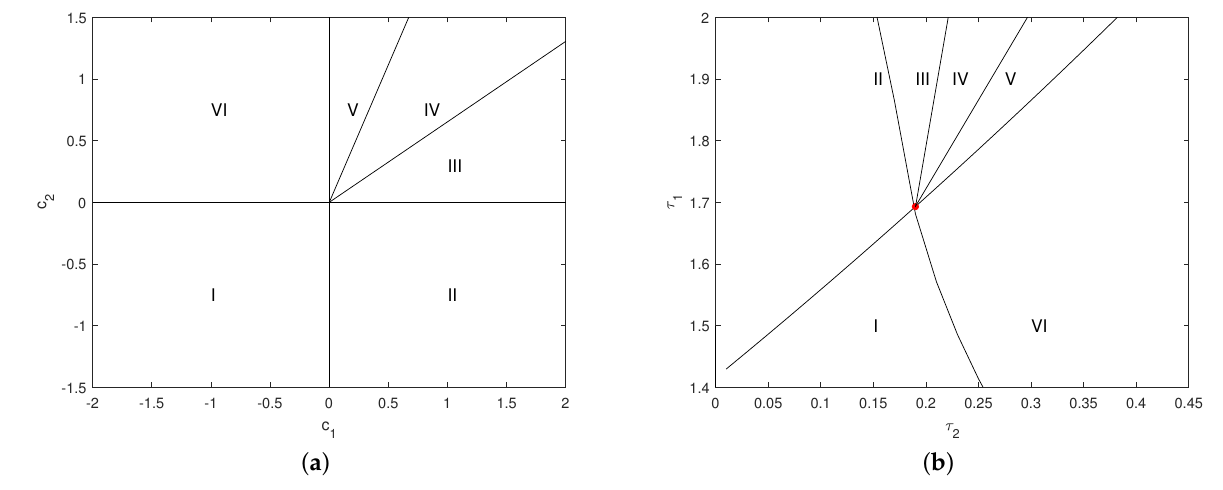
Figure 6. Classification of the double Hopf bifurcation in ( a ) c 1 − c 2 ; ( b ) τ 2 − τ 1